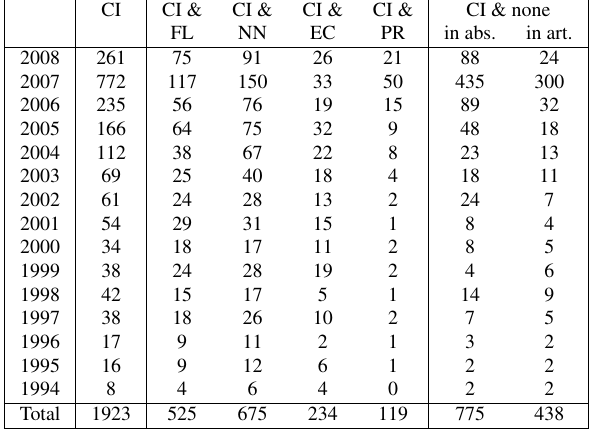
Table 2. Articles in Scopus containing the term “Computational